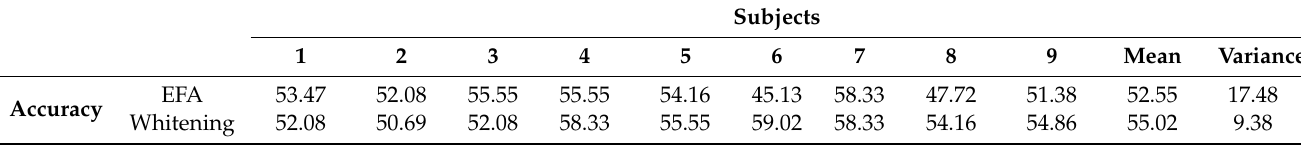
Table 6. Variance comparison according to classification methods for C4D2a_2C.